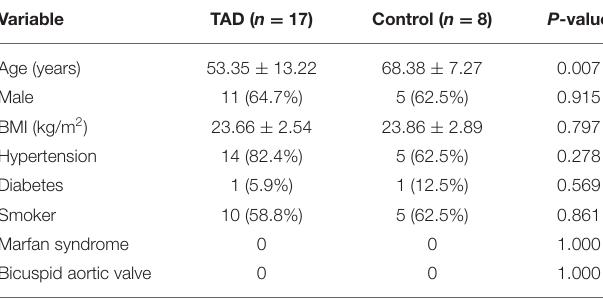
TABLE 1 | Characteristics of the TAD group and control group in the screening phase.